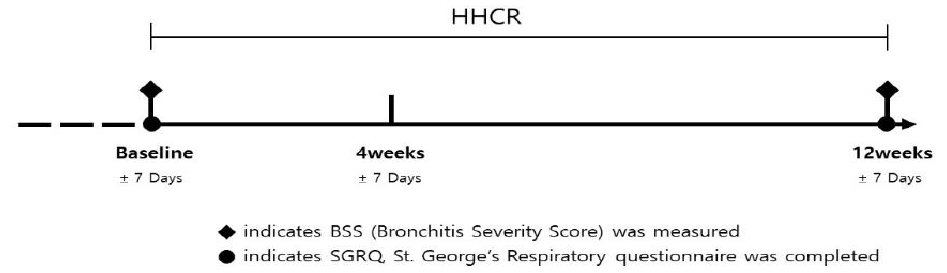
Figure 1. Study design.